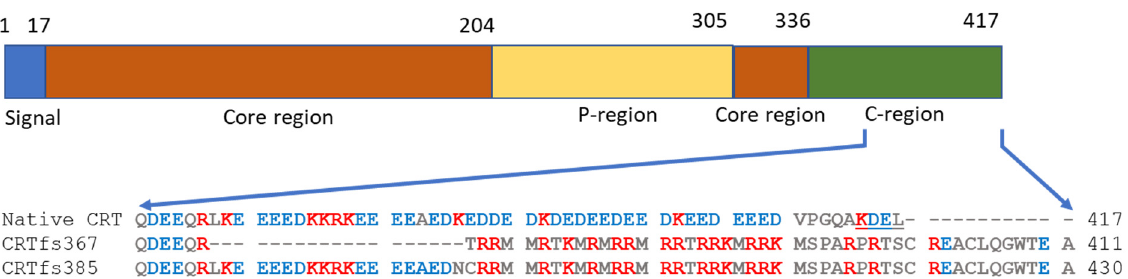
Figure 1. Schematic presentation of calreticulin (CRT) and location of C-terminal frameshift substitutions. The different regions are coloured according to Boelt et al. [13], and the C-terminal part from residue 361 of native CRT, CRTfs L367, and CRTfs K385 are highlighted (bottom). Acidic residues are coloured blue while basic residues are coloured red. The KDEL sequence of native CRT is underlined.